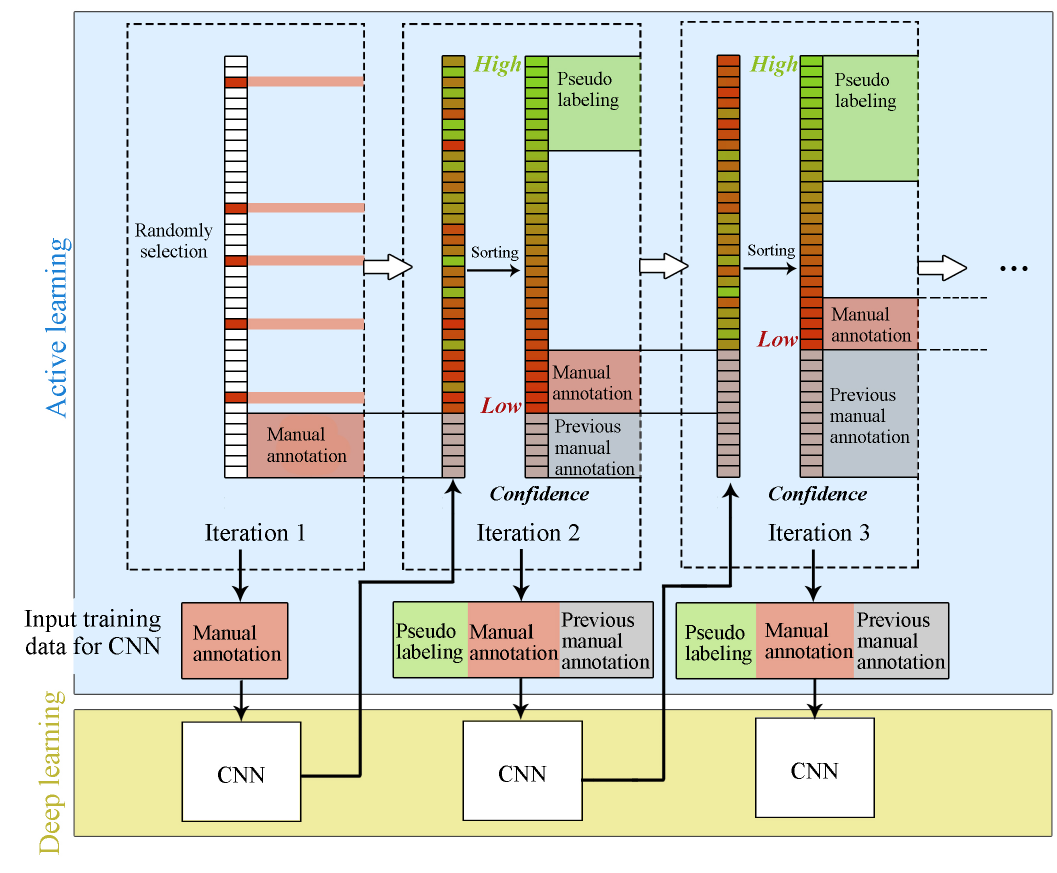
Figure 1. The application of active learning in the proposed